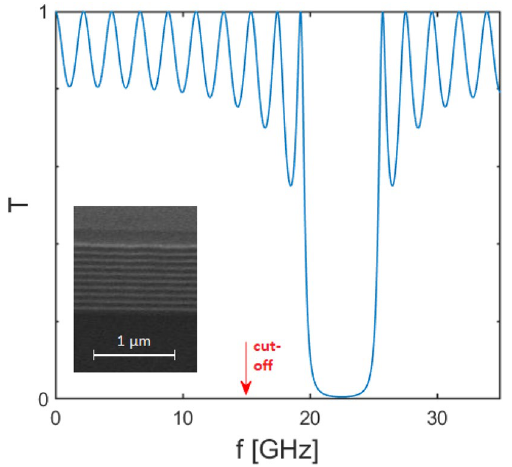
Figure 2. Acoustic transmission function of the Ti/Ag-Bragg lattice sample (ten periods) simulated for the target quarter-wavelength dimensions by the transfer matrix method, where the red arrow indicates the approximate lower cut-off frequency of the NA = 1.4 objective used in the present study (inset: scanning electron microscopy image of the manufactured